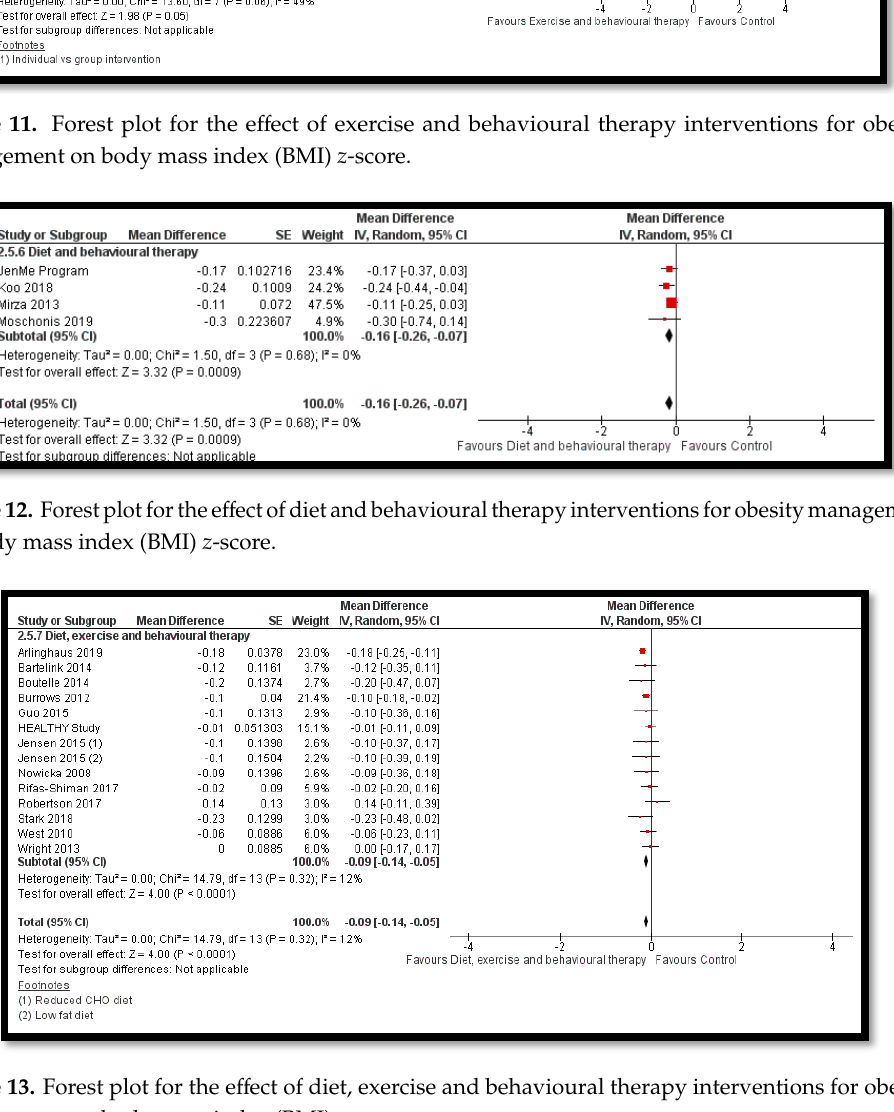
Figure 14. Forest plot for the effect of behavioural therpy only interventions for obesity management on body mass index (BMI) .